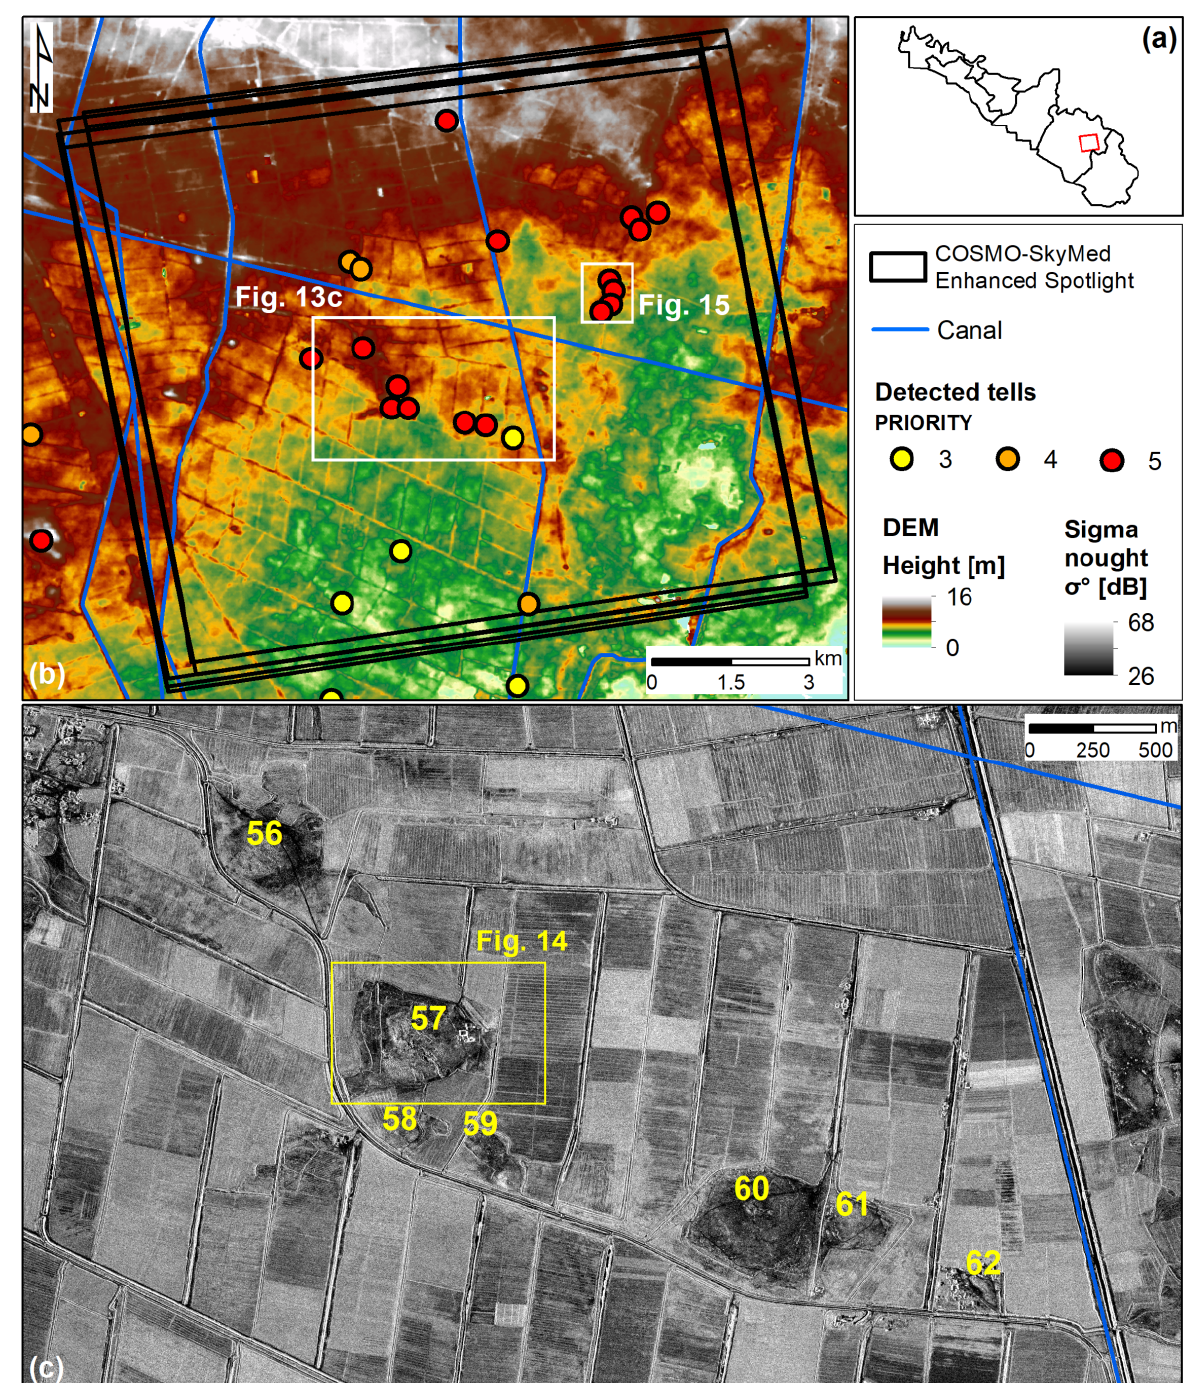
Figure 13. ( a ) Location of the area covered by ( b ) the bespoke time series of COSMO-SkyMed Enhanced Spotlight images collected in the period 27 July 2019–24 March 2020 to monitor the condition of ( c ) a cluster of high to very high priority tells (precise location undisclosed for security concerns). COSMO-SkyMed ® Products ©ASI, Italian Space Agency, 2019–2020. All rights reserved.